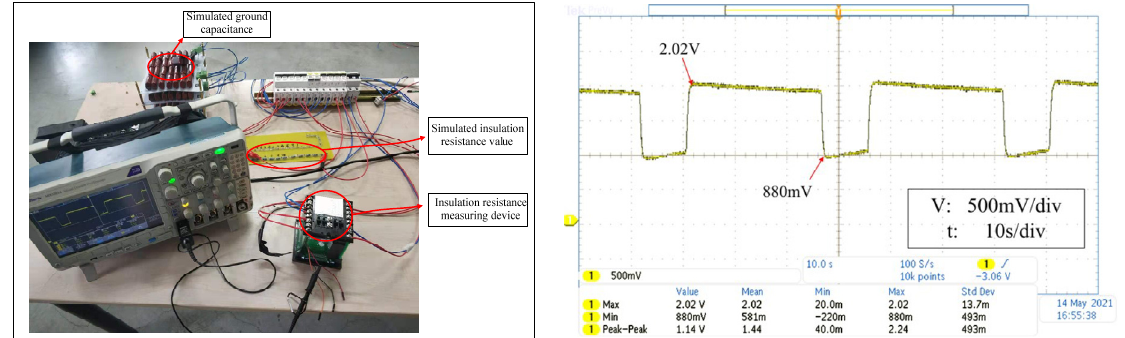
Figure 5. The left side is the cable insulation resistance measurement experiment, and the right side is the waveform of sampling resistance at both ends when R f = 6M Ω and C f = 100uF.